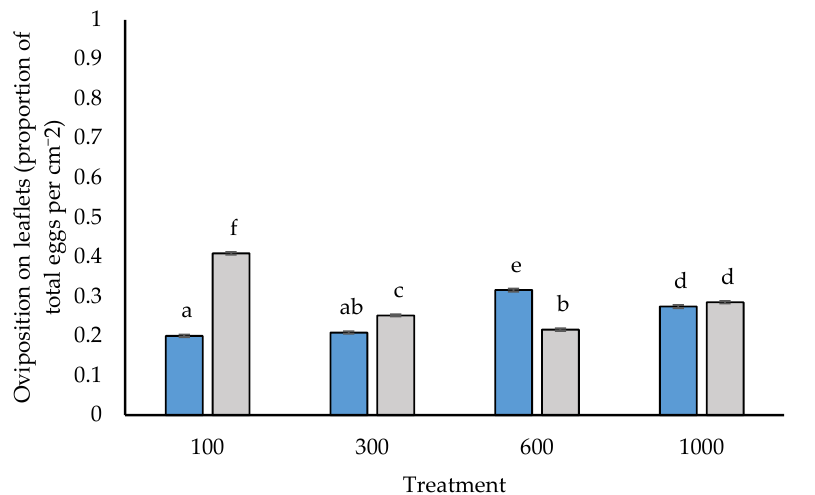
Figure 6. Ommatissus lybicus oviposition on leaflets (proportion of total eggs per cm − 2 palm area) in experiments. Predicted means with standard error bars were derived by generalized linear model with binomial distribution and link function of logit ( p < 0.001). Fisher’s least significant difference test was used for comparisons. Different letters indicate statistically significant differences ( p < 0.05) between means. Experiment = E.